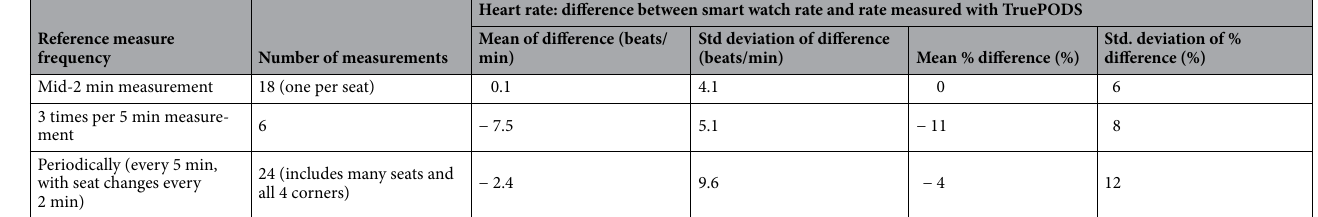
Table 4. Analysis of heart rate estimation